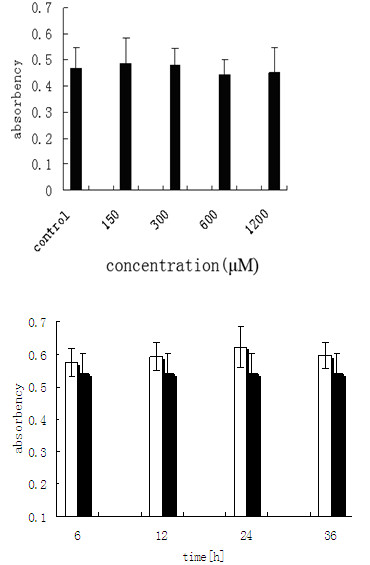
Cell viability in the presence of acetyl salicylic acid. Cell viabilities treated by different concentrations of ASA (A) or at different time points (B) with 600 μM ASA were determined by the MTT assays as described in Methods and Materials. Results are represented as mean±S.D from at least three experiments with duplicated samples. No changes of cell viability at different time points and concentrations of ASA.